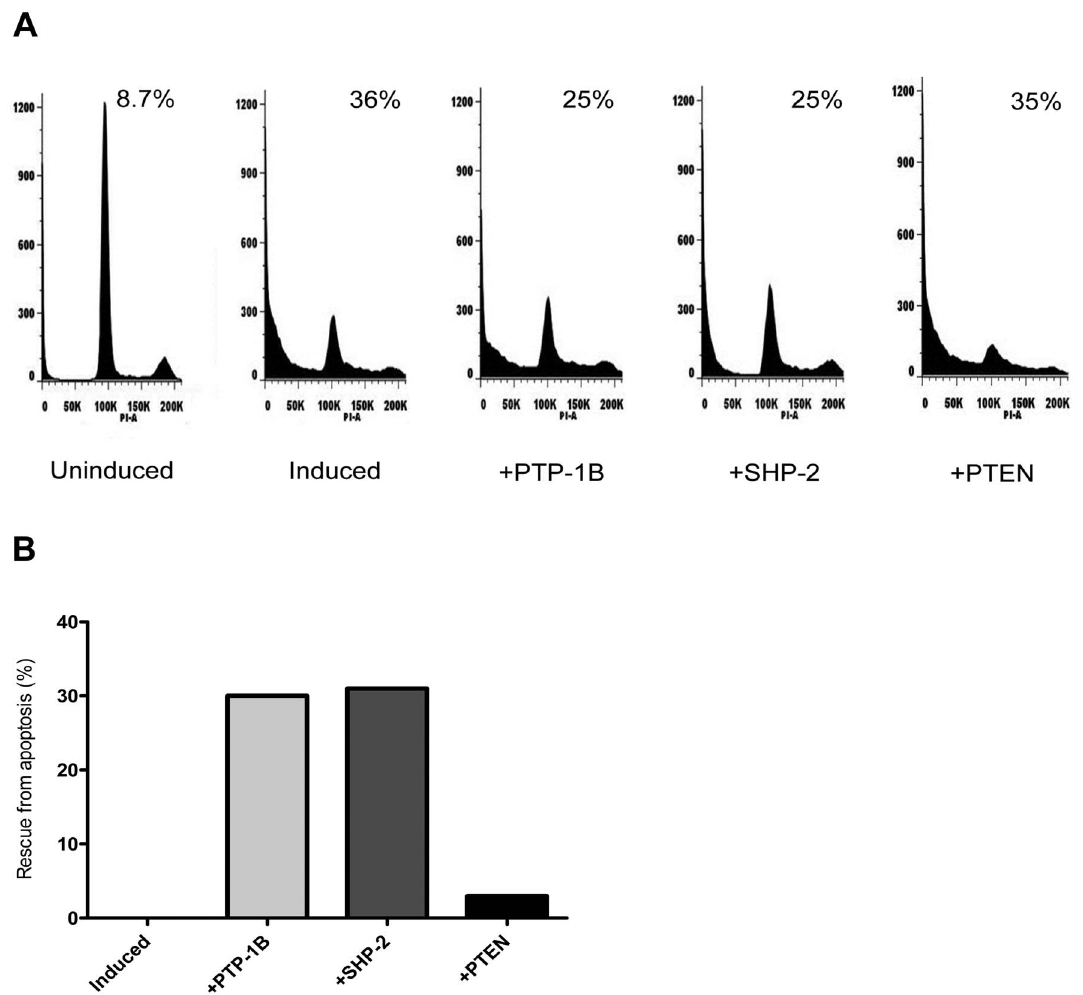
Figure 4. Knockdown of PTP expression rescues cells from Rb/E2F-associated apoptosis. ER-dnE2F1 cells were transfected with siRNA specific for PTP-1B ( + PTP-1B), SHP-2 ( + SHP-2), or PTEN ( + PTEN). Uninduced and induced control cells were transfected with scrambled siRNA. Then cells were treated with 4-OHT for 48 h to trigger apoptosis. Uninduced control cells were left untreated. (A) DNA content was measured by flow cytometry. (B) Apoptosis rescue is expressed as the reduction of cells with , 2N DNA content compared with induced control